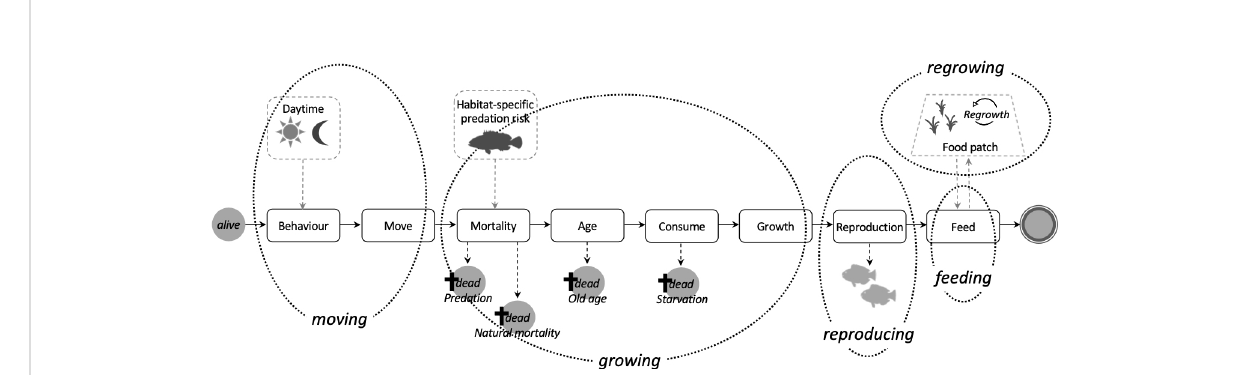
FIGURE 2 Schematic overview and execution order of main modules and model processes (in italics). Dotted black lines indicate which modules of a fi sh ’ s life loop are part of a certain process. Dashed grey lines and arrows illustrate in fl uencing environmental